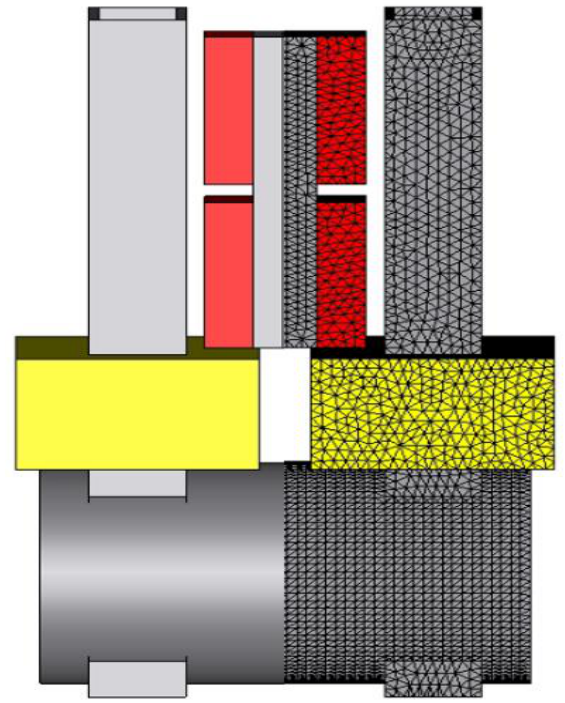
Figure 3. LAT 3D model and mesh in JMAG Designer.